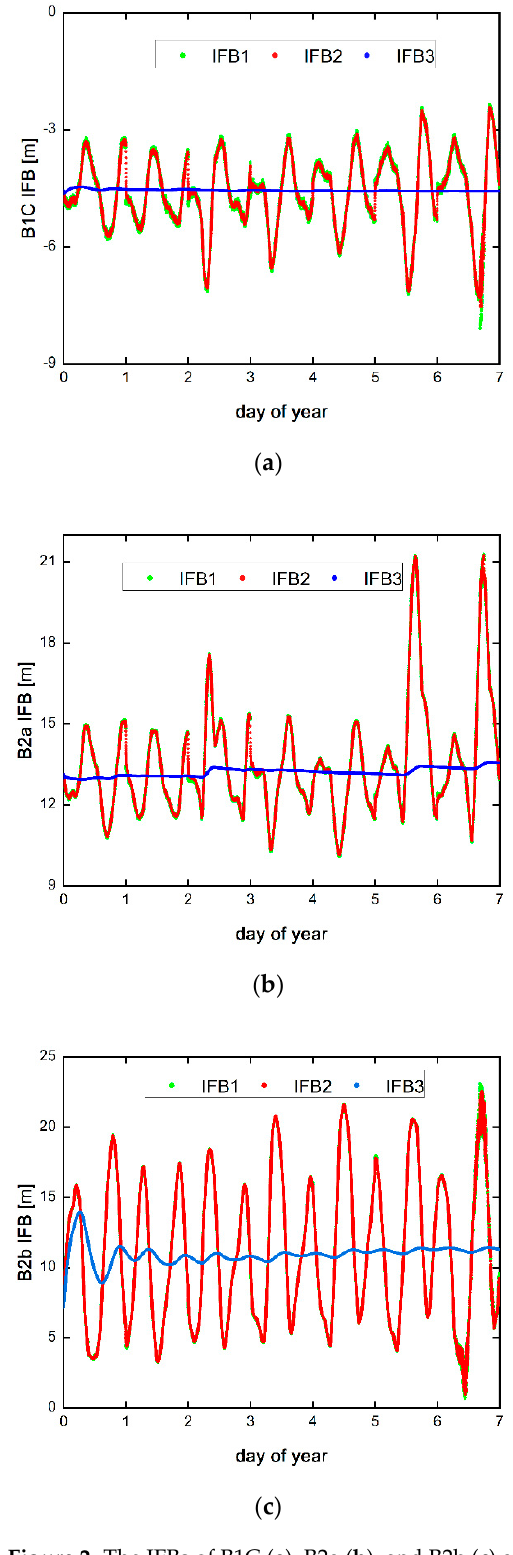
Figure 2. The IFBs of B1C ( a ), B2a ( b ), and B2b ( c ) among different IFB handling schemes for station KRGG on day of year (DOY) 001 to 007 in 2022. IFB1, IFB2, and IFB3 represent three stochastic modeling methods of white noise, random walk, and time constant, respectively.